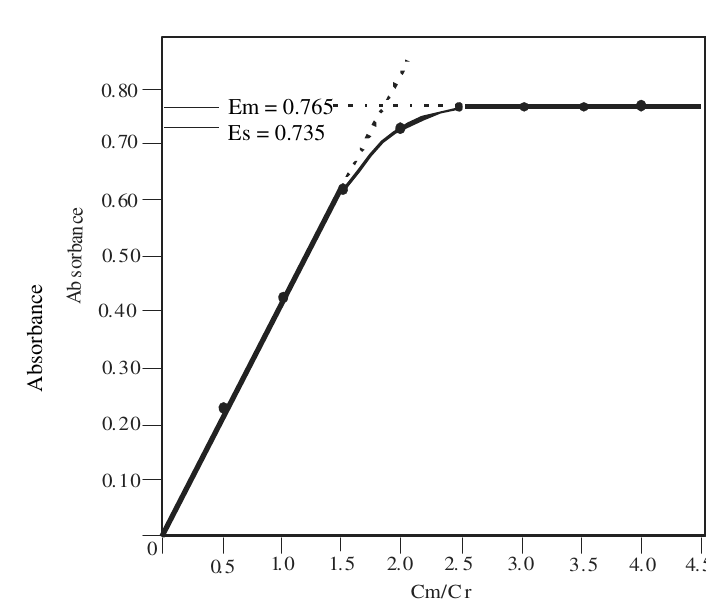
Graph - 3 : Mole ratio method for Cu(II)-HMBO complex Yoe and Jone’s mole ratio method for determination of M:L ratio 0.005 M Cu(II), 0.005 M HMBO; pH = 5.0; λ = 400